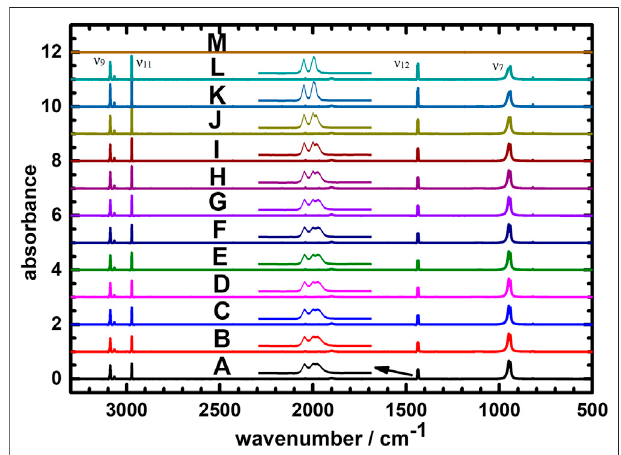
FIGURE 5 | IR absorption spectra of icy C 2 H 4 recorded at temperatures (A) 8 K, (B) 10 K, (C) 12 K, (D) 14 K, (E) 18 K, (F) 20 K, (G) 30 K, (H) 40 K,